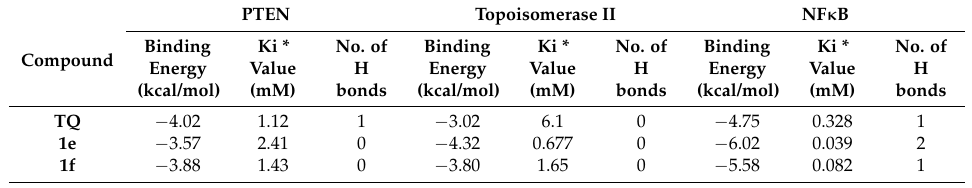
Table 4. Binding characteristics of TQ , 1e and 1f to phosphatase and tensin homolog located on